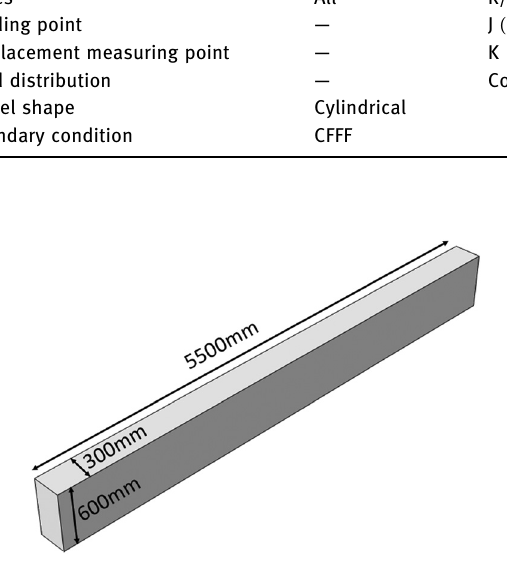
Figure 3: Schematic drawing of the beam.